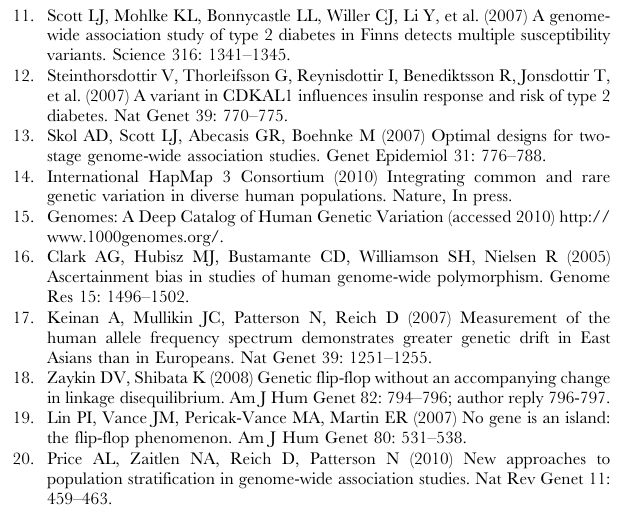
Table S3 Power to detect an association for a sample size of 80,000 using HapMap 3 data. Power is calculated for individual population